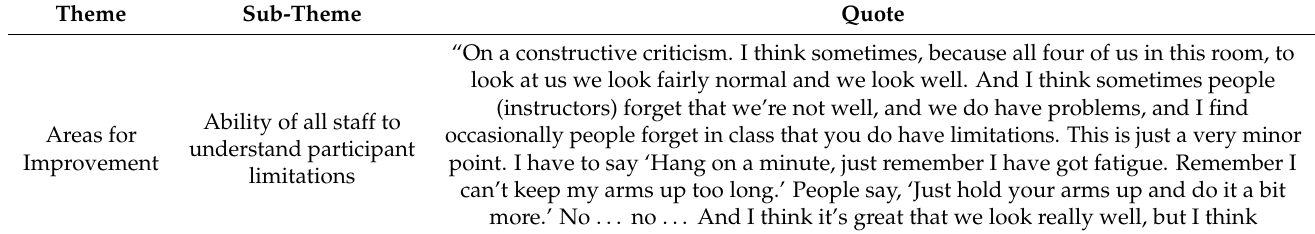
Table 9. Overall maintenance themes, sub-themes and participant quotes related to their experience of CARE. Theme